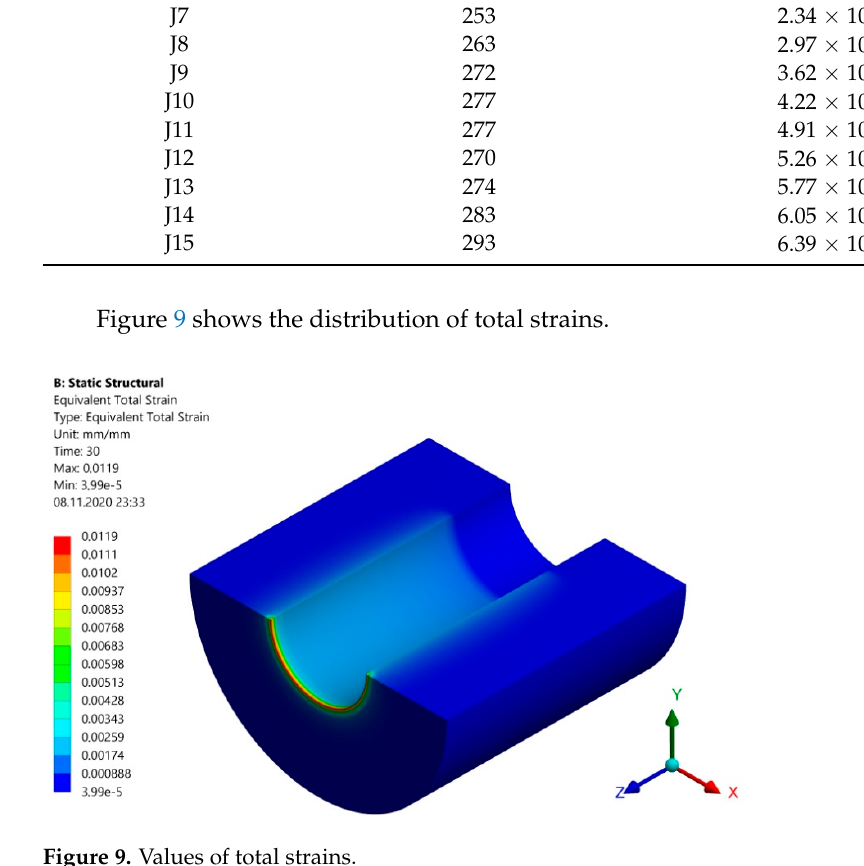
Figure 9. Values of total strains.